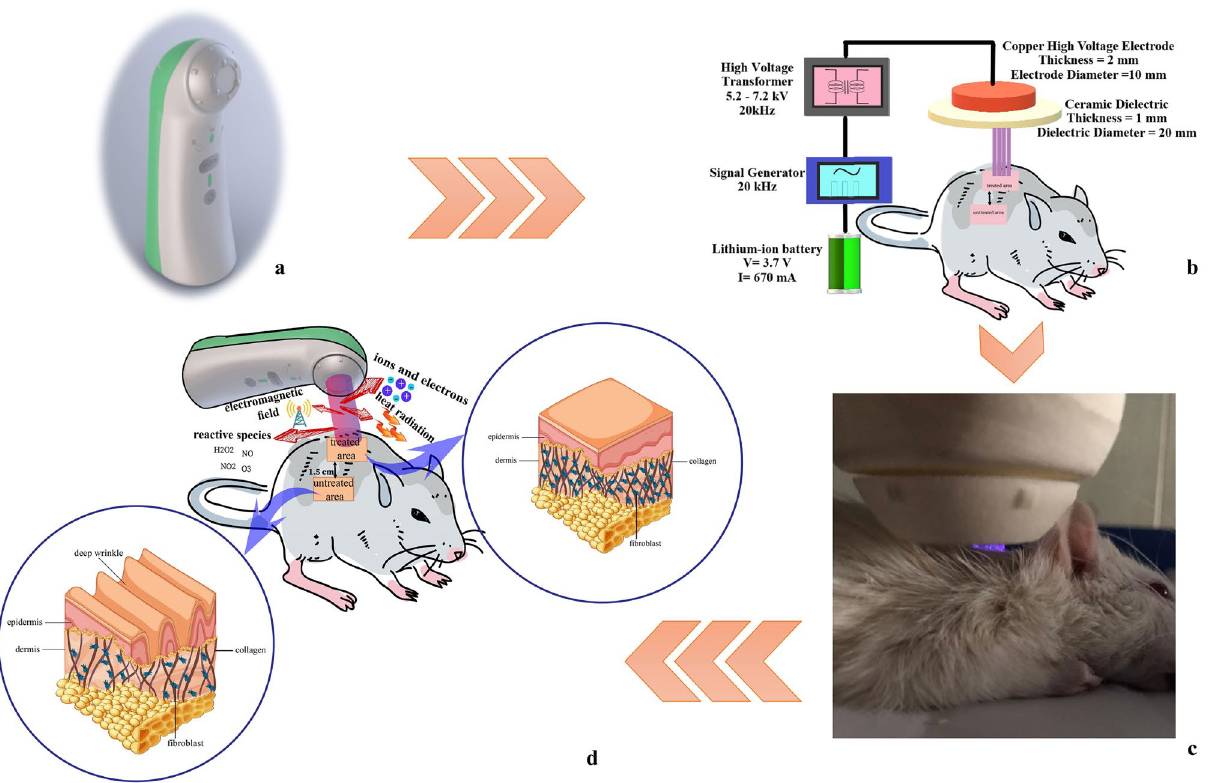
Figure 1. Plasma device and the process of treatment ( a ) The appearance of plasma device, ( b ) the schematic of the internal structure of the plasma device, ( c ) treating skin with cold plasma radiation, ( d ) schematic diagram of treating the skin of a rat by portable plasma device.